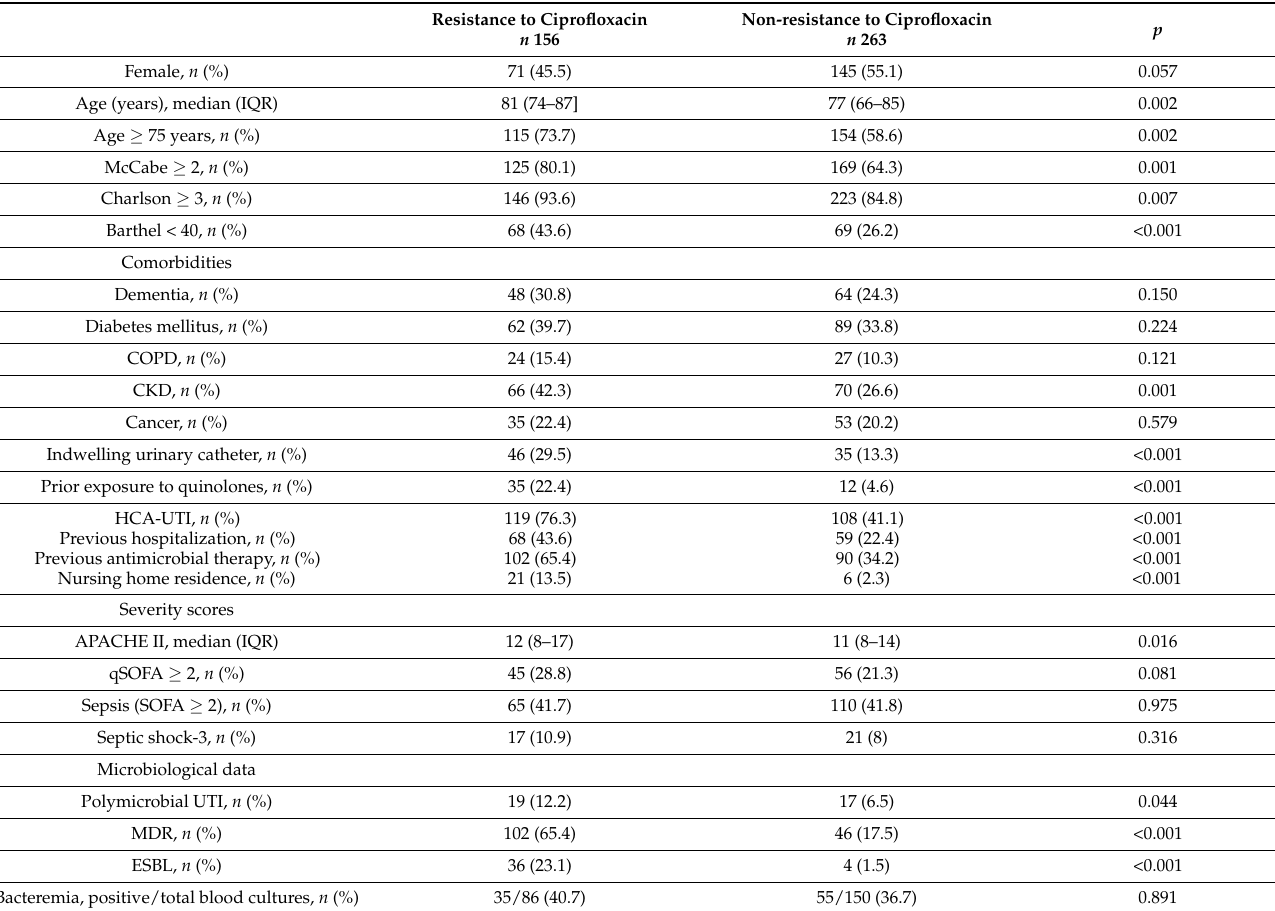
Table 2. Risk factors for resistance to ciprofloxacin of complicated community-acquired urinary tract